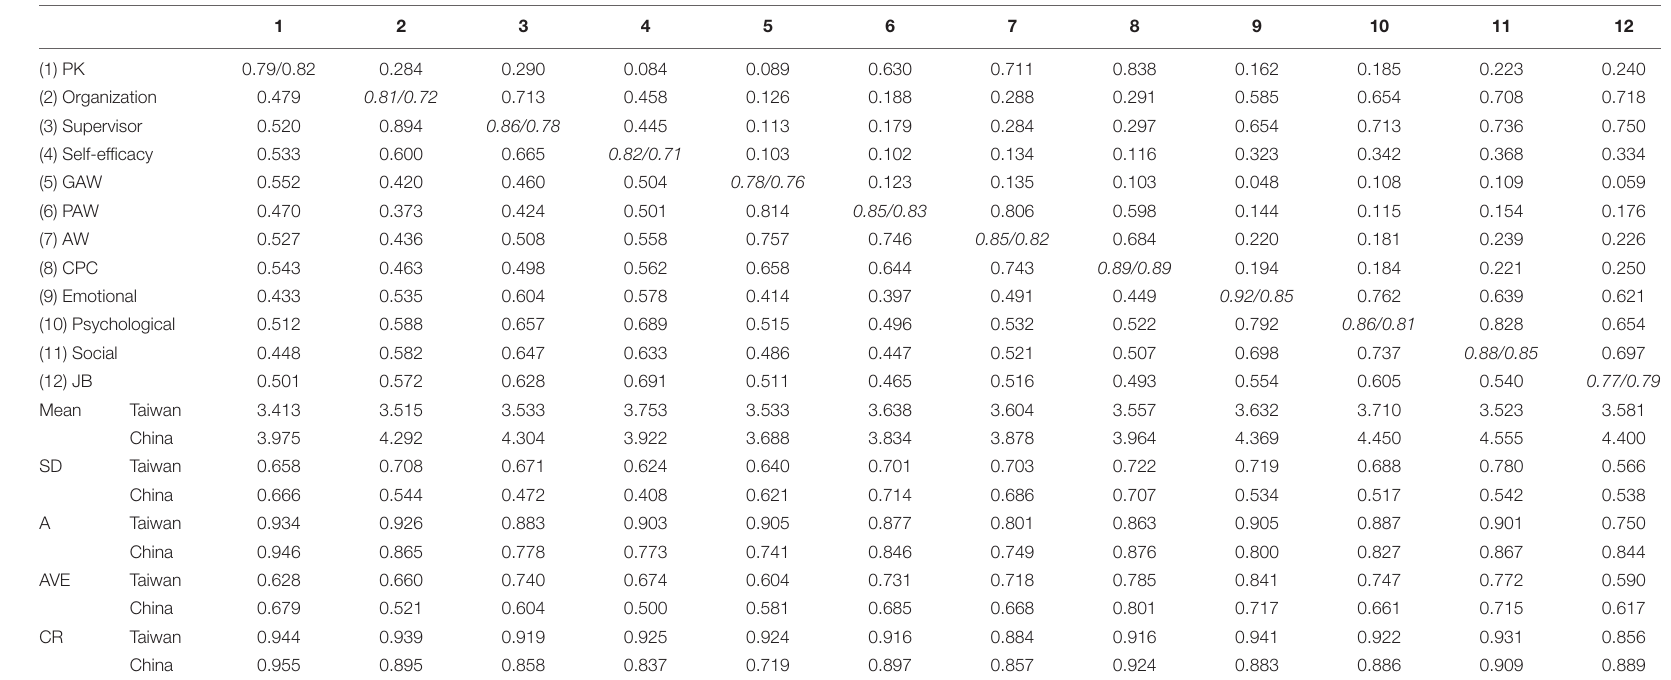
TABLE 1 | Measurement